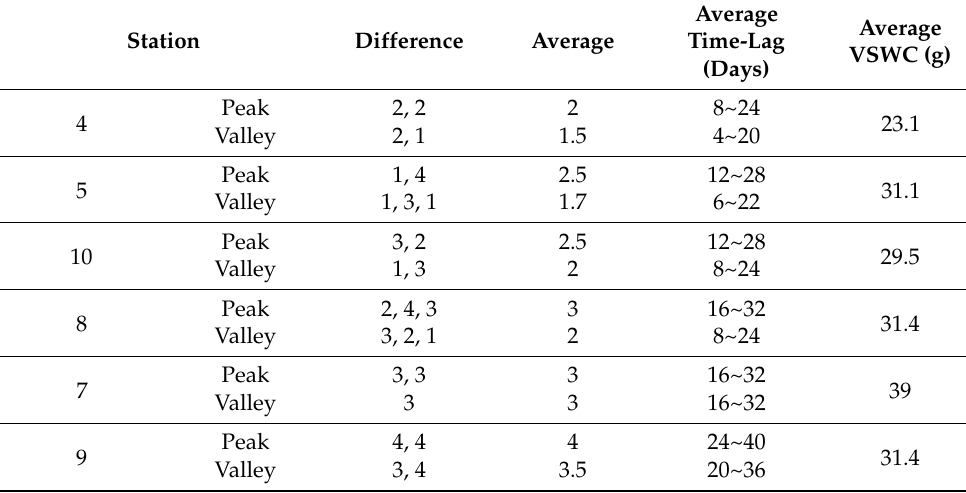
Table 5. Statistics of difference between peak/valley of